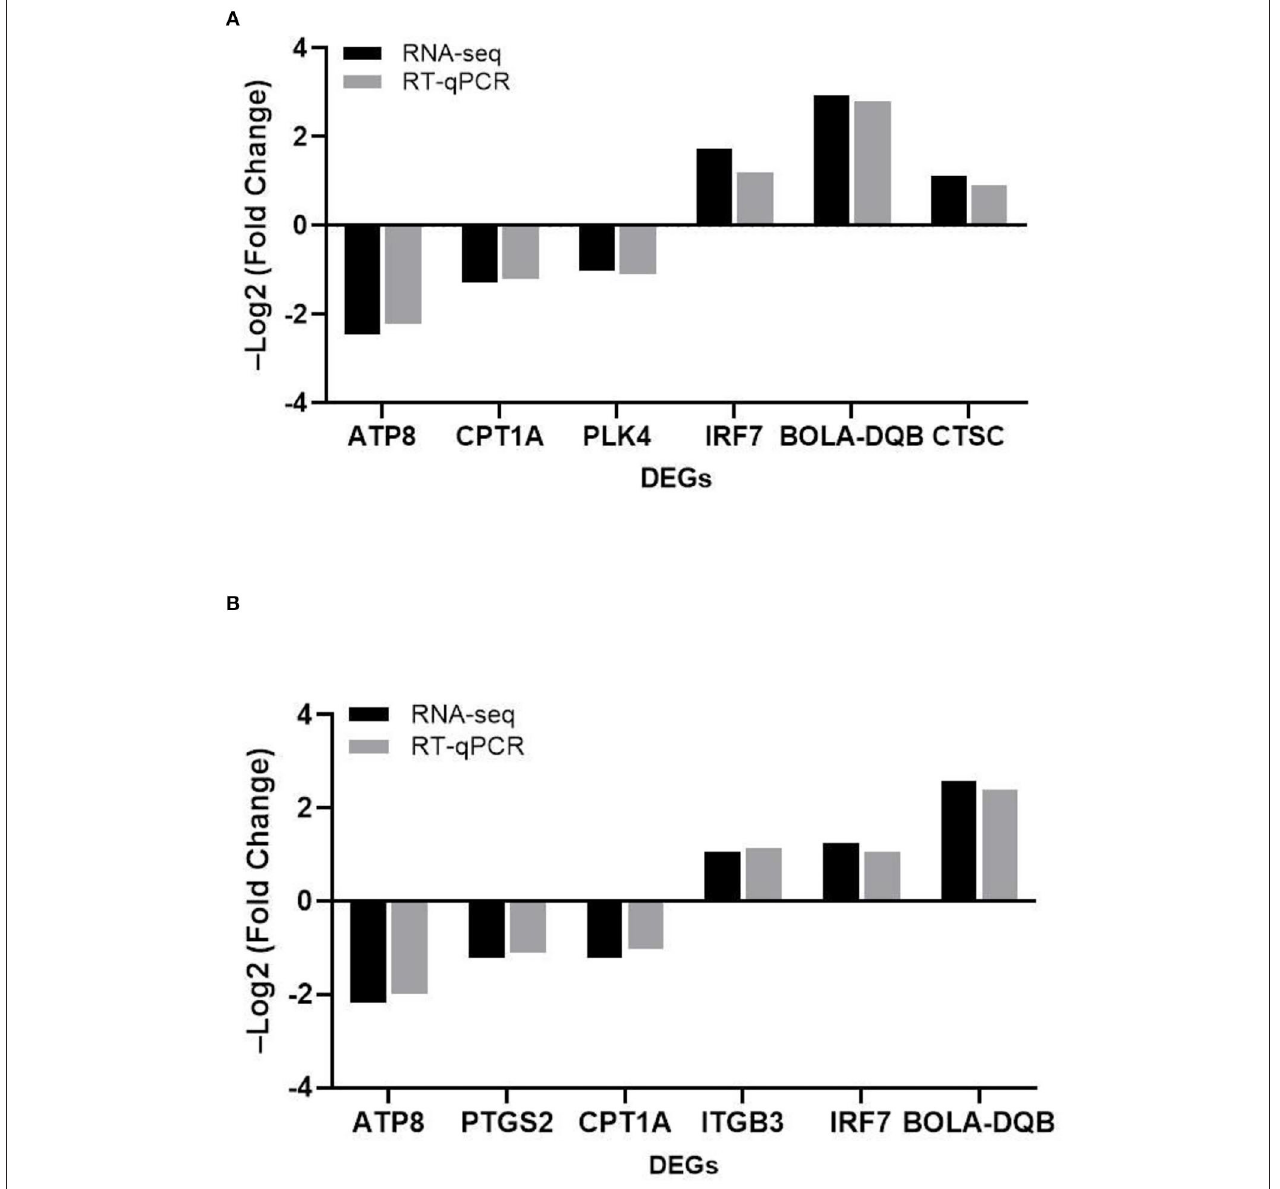
FIGURE 5 | The comparison of the relative expression of DEGs screened by RT-qPCR and RNA-seq for the MRSA-infected and MSSA-infected groups. (A) RT-qPCR to detect the relative expression of DEGs screened from the MRSA-infected group. (B) RT-qPCR to detect the relative expression of DEGs screened from the MSSA-infected